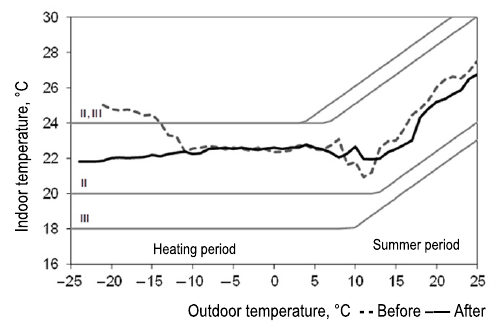
Fig. 5. Measurement results of indoor air temperature depending on the outdoor air temperature before and after the